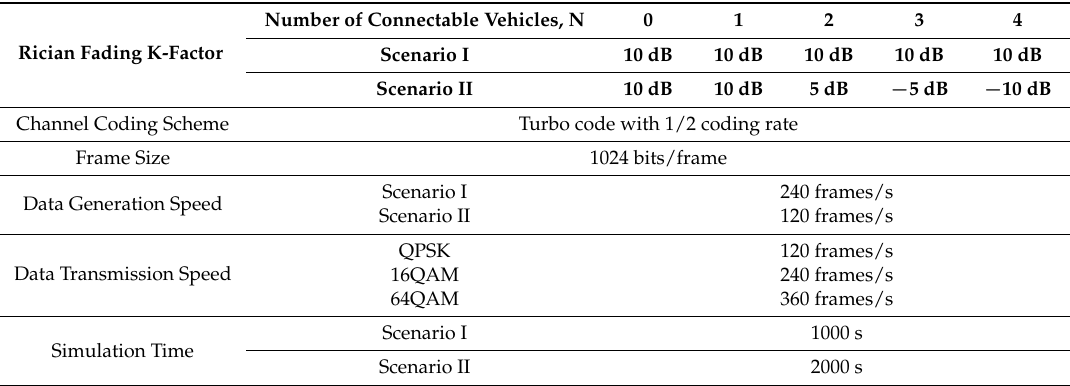
Table 3. Simulation parameters for scenarios I and